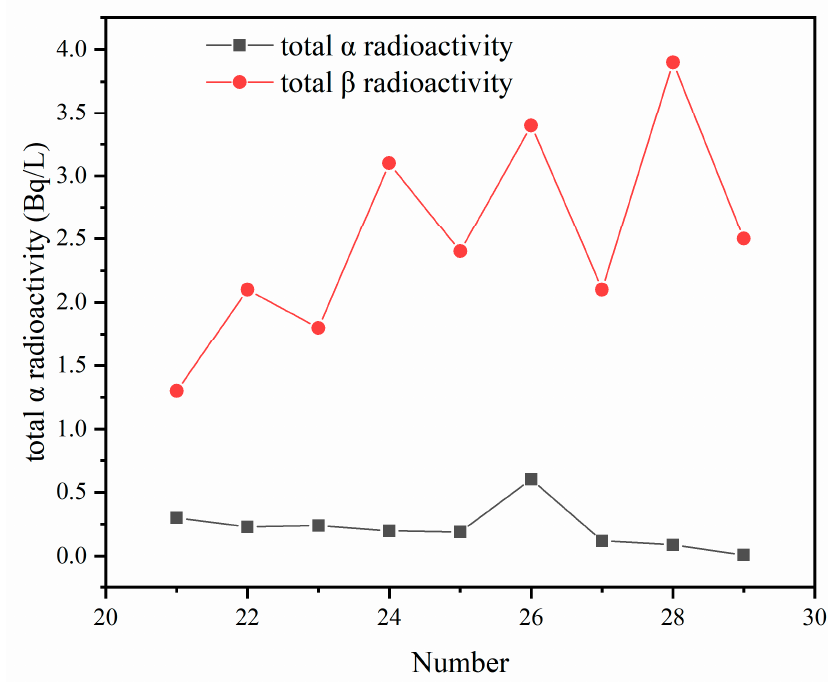
Figure 13. The total content of leaching solution with different formula α and β radioactivity.